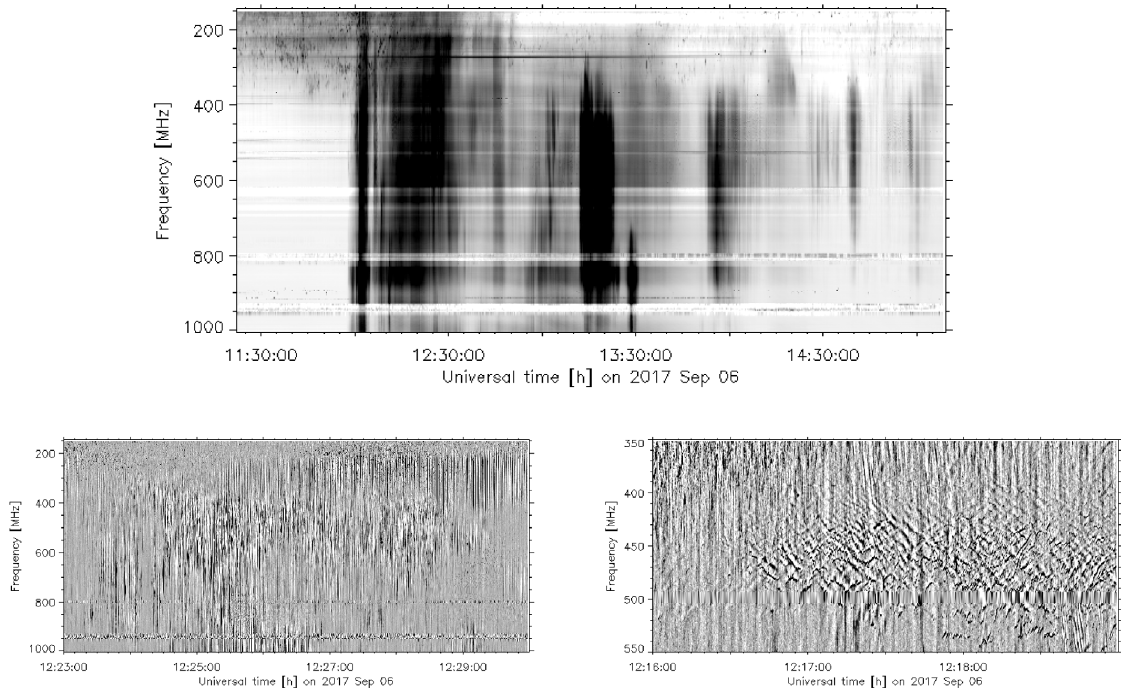
Fig. 9. Dynamic spectrum of a type IV burst on 2017 September 06. Top panel: the entire event. Bottom panels: two episodes of fi ne structure (a sliding median was subtracted over 3 s and 10 s,